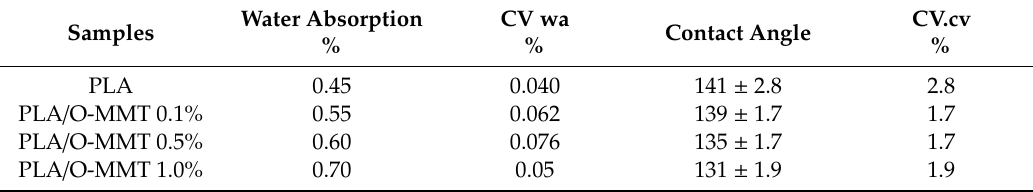
Figure 10. DSC of PLA, Neat CTAC-MMT, and PLA / CTAC-MMT nanocomposites. Table 3. Contact angle and water absorption data for electrospun PLA nanofibers membrane and PLA / CTAC-MMT